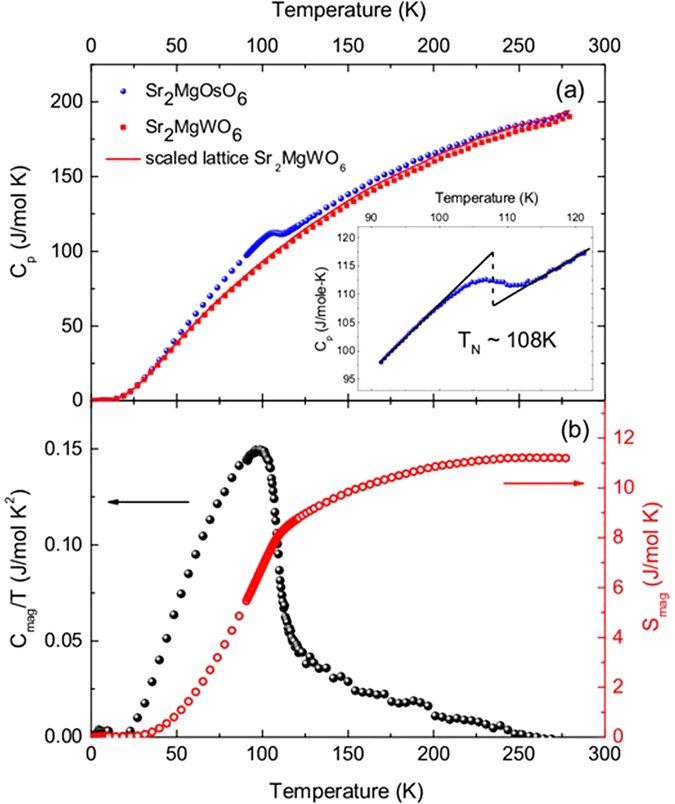
(a) The temperature dependence of the specific heat of Sr2MgOsO6 (blue) and diamagnetic Sr2MgWO6 (red) which is used to approximate the lattice specific heat of S2MgOsO6. (b) The magnetic specific heat (black) of Sr2MgOsO6 taken by subtracting the scaled specific heat of Sr2MgWO6 and magnetic entropy (red) obtained by integration.